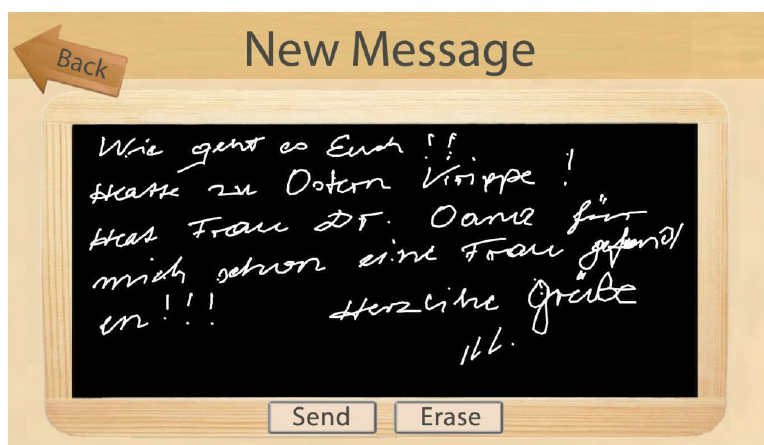
Figure 6. Handwritten (e-mail)